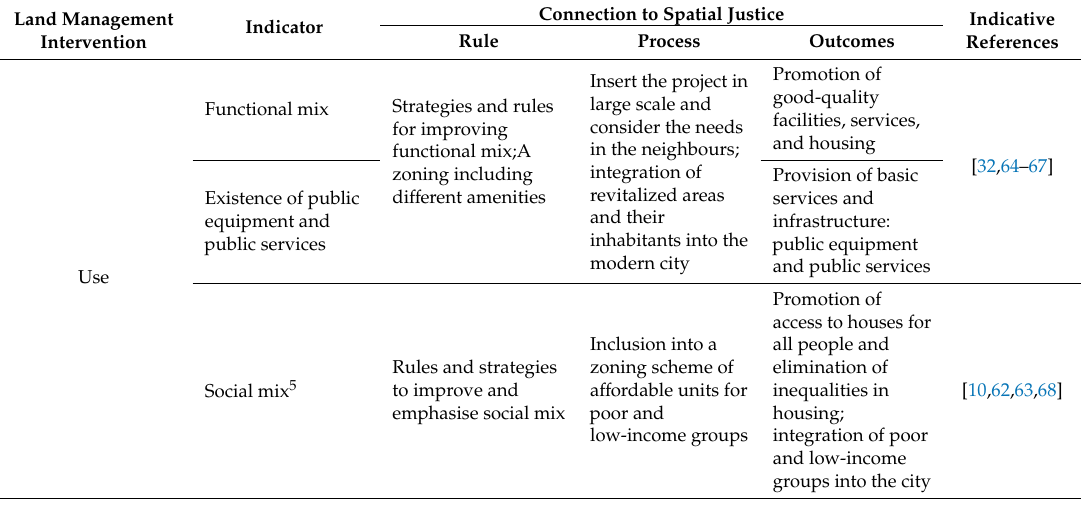
Table 2. Indicators related to use of